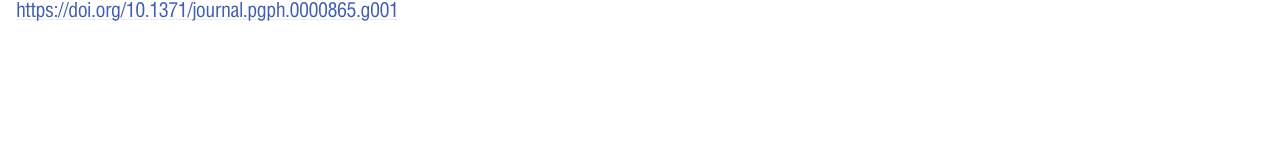
PLOS Global PublicHealth | https://doi.org/10.1371/journal.pgph.0000865 December 13,